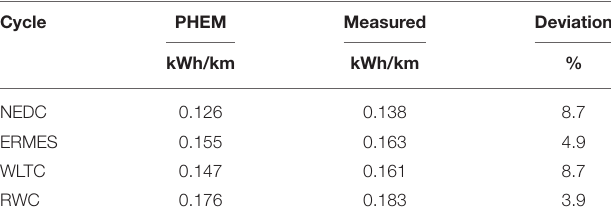
TABLE 11 | Electrical consumption measured and simulated at TUG (Matzer et al., 2019). Cycle PHEM